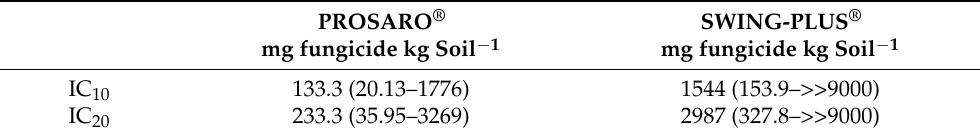
Table 6. The 20% and 10% inhibition concentrations (IC 10 and IC 20 ) and estimations (IC95%) for two fungicide formulations considering performance in terms of number of juveniles. Based on results from Toxicity test 1.